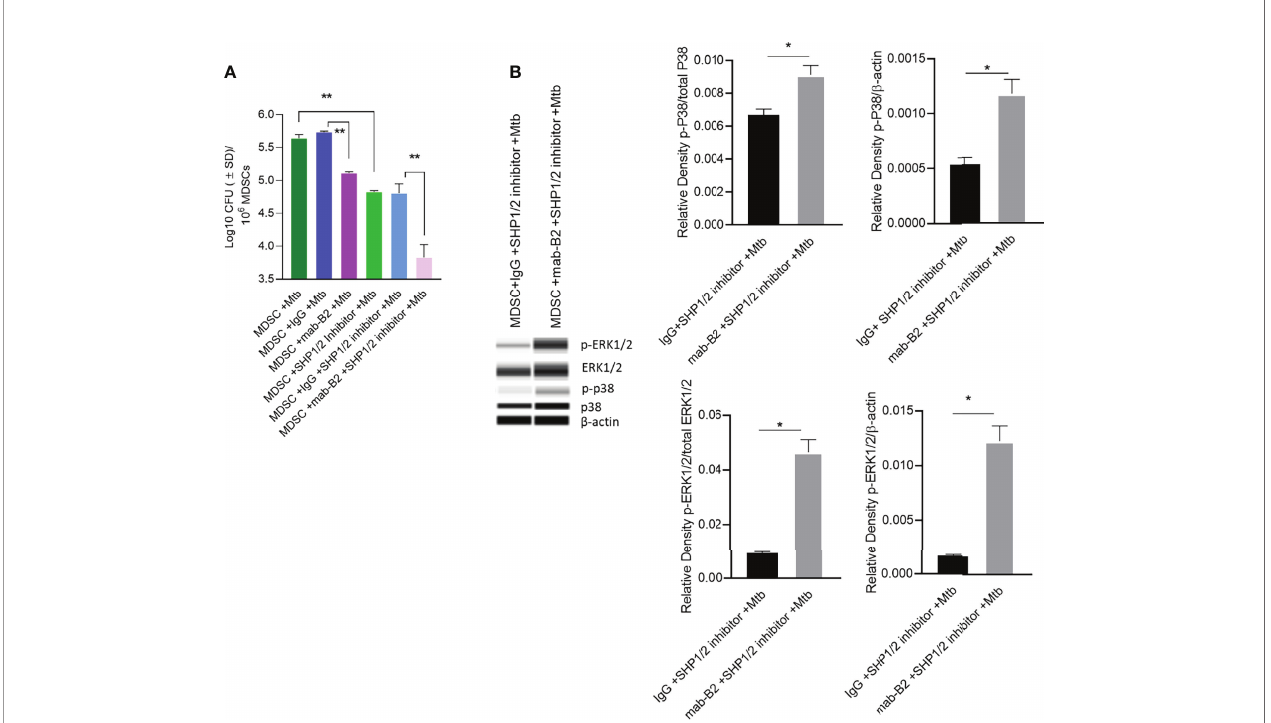
FIGURE 6 | Mab-B2 antagonism of LILRB2 and pharmacological inhibition of SHP1/2 synergistically boost killing of Mtb in MDSCs. CD14 + /CD33 + bead-puri fi ed M- MDSCs derived from GM-CSF/IL-6 cultured PBMCs from donors were infected for 4 h with Mtb H37Rv (MOI = 1), washed, and activated using either a monoclonal antibody to LILRB2 (mab-B2) or its IgG isotype with or without added SHP-1 and SHP-2 inhibitors (1 µg/ml each per 10*6 cells). (A) MDSC lysates collected 18 h after infection were plated for Mtb CFUs on 7H11 agar (** p < 0.002 by 1- way ANOVA with Tukey ’ s posttest; 1 of 2 similar experiments shown). (B) Lysates collected from replicate cultures of MDSCs were analyzed using Wes simple Western blot for phosphorylated ERK1/2 and p-38 kinases, and densitometry is shown to the right (* p < 0.02, unpaired t